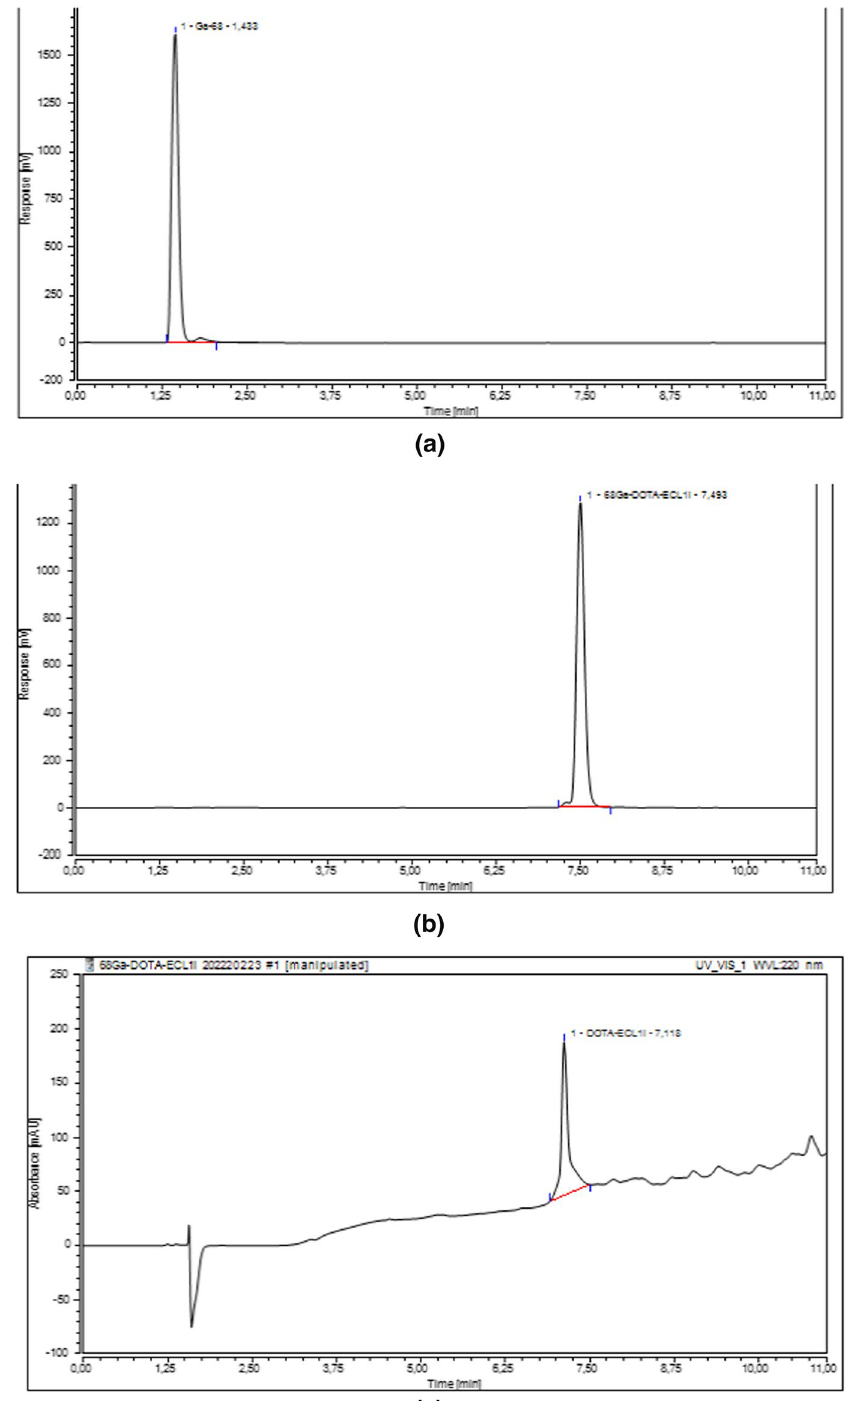
Fig. 1 a HPLC chromatogram of the radiodetector showing the eluate [68Ga]68GaCl 3 ; b HPLC chromatogram of the radiodetector showing [68Ga]68Ga-DOTA-ECL1. The small minor peak just before [68Ga]68Ga-DOTA-ECL1 belongs to [68Ga]68Ga-DOTA-ECL1peak, infact in UV chromatogram there is only the peak of DOTA-ECL1i (Fig. 1c); c Radio-UV-HPLC chromatogram of